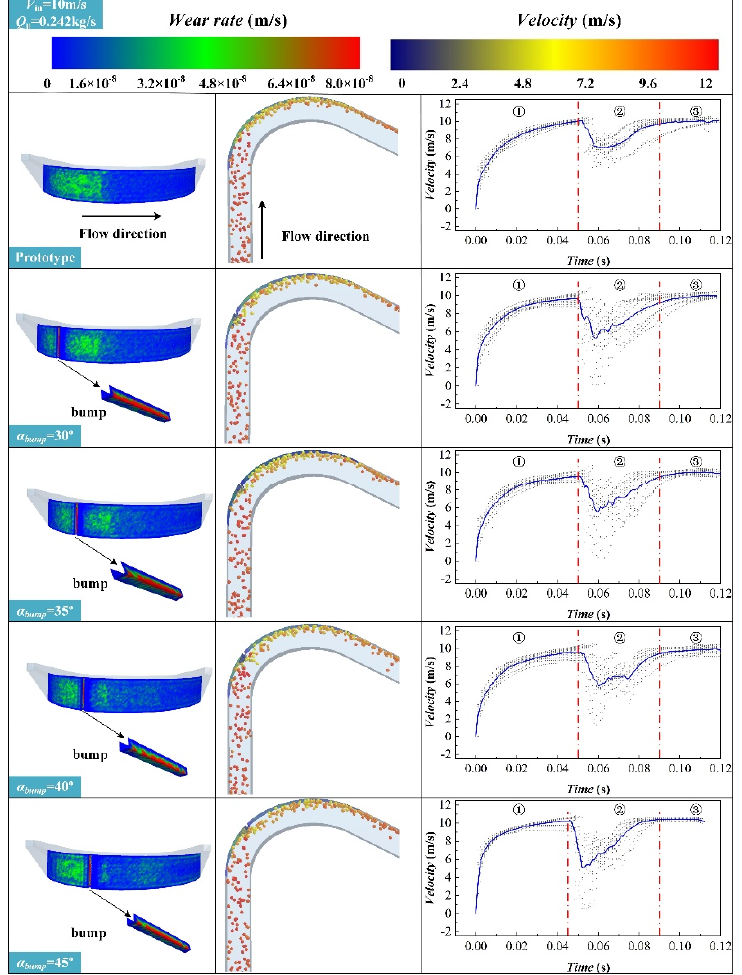
Figure 8. The relationship between the wear rate and the fluid and particle movement left column: the wear cloud diagram on the outer bend wall with different convex positions, middle column: the particle distribution and the velocity diagram inside the flow passage, right column: the velocity variation diagram of the 12 particles selected to be tracked over time.